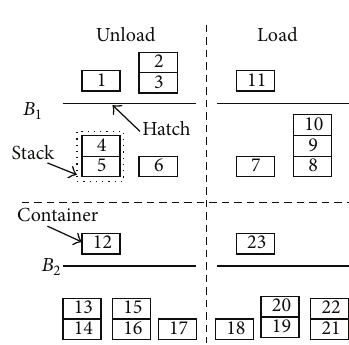
Figure 3: Stowage plan for two bays.